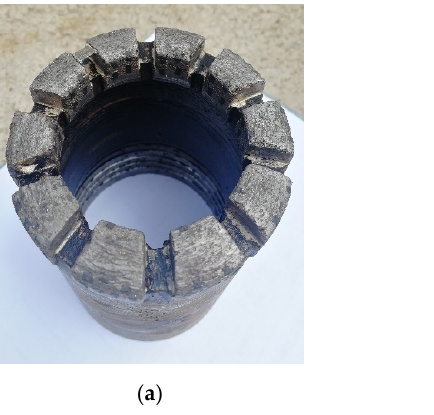
Figure 7. ( a ) Wear condition of bit; ( b ) Retrieved core.